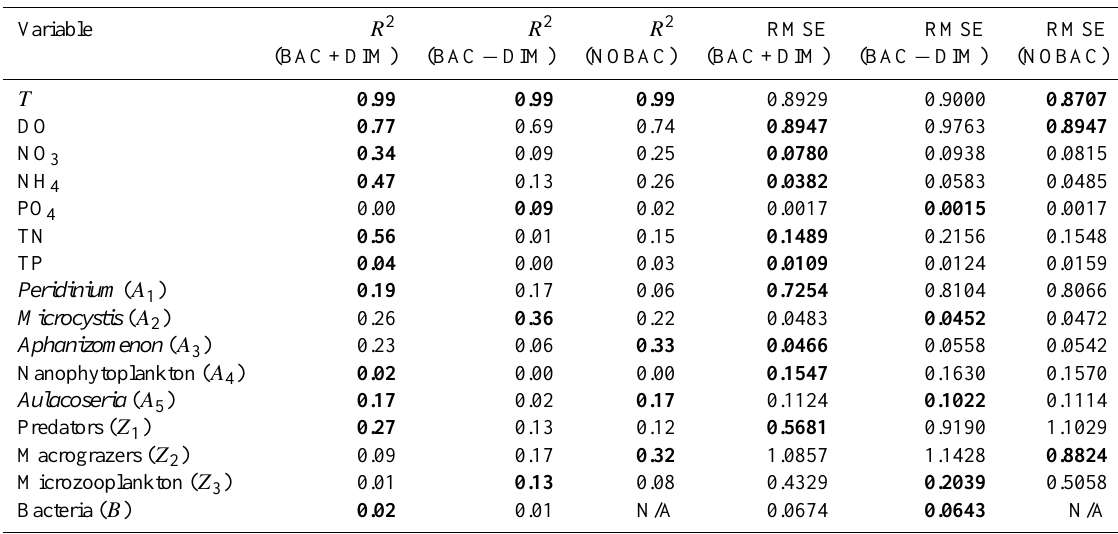
Table A1. Comparison of R 2 and RMSE model validation metrics for the surface 10m of Lake Kinneret for the main simulated variables. The best performing model configuration is highlighted